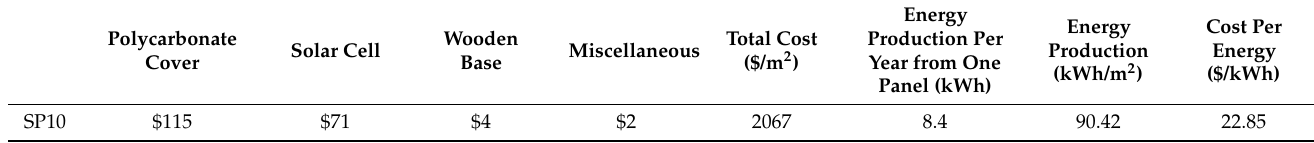
Table 8. Cost per unit area and energy production of solar panel.